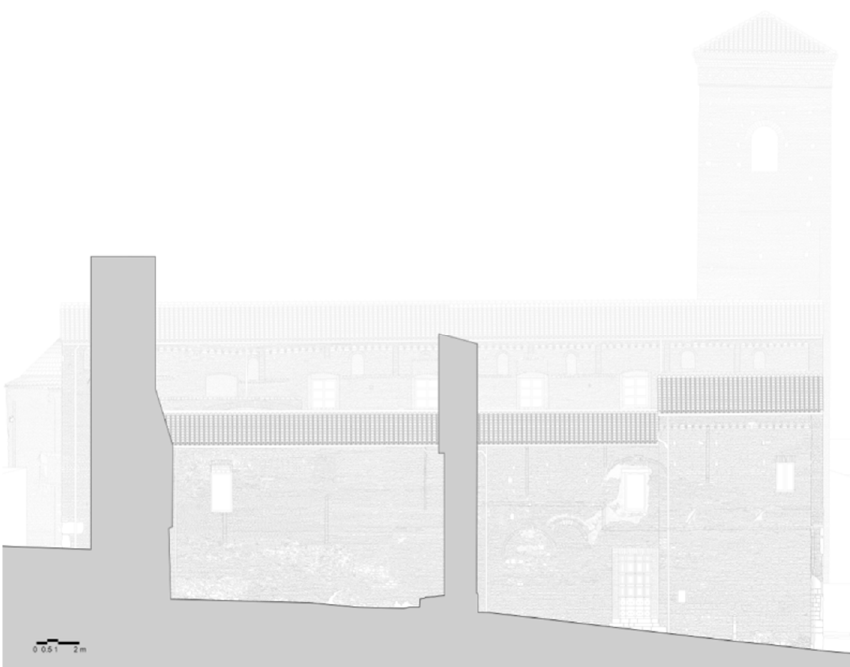
Figure 7. Eastern prospect of the building (architectural survey).